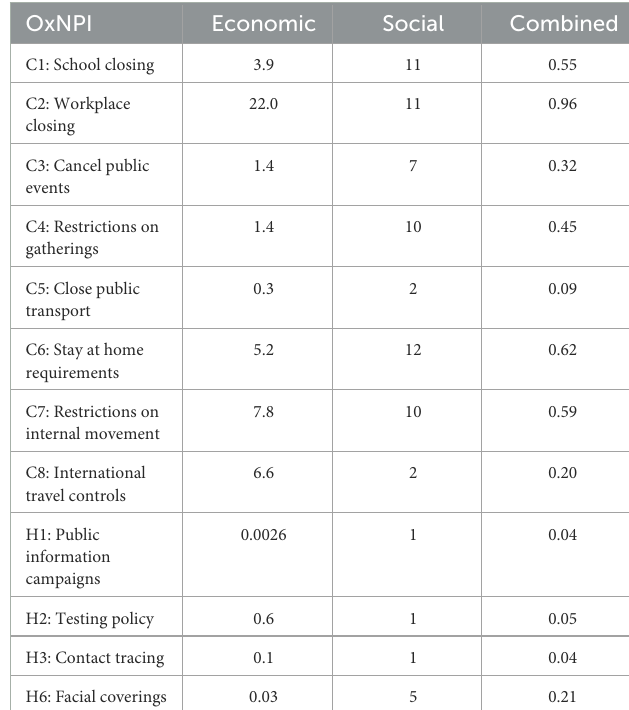
TABLE 1 Social and economic costs for